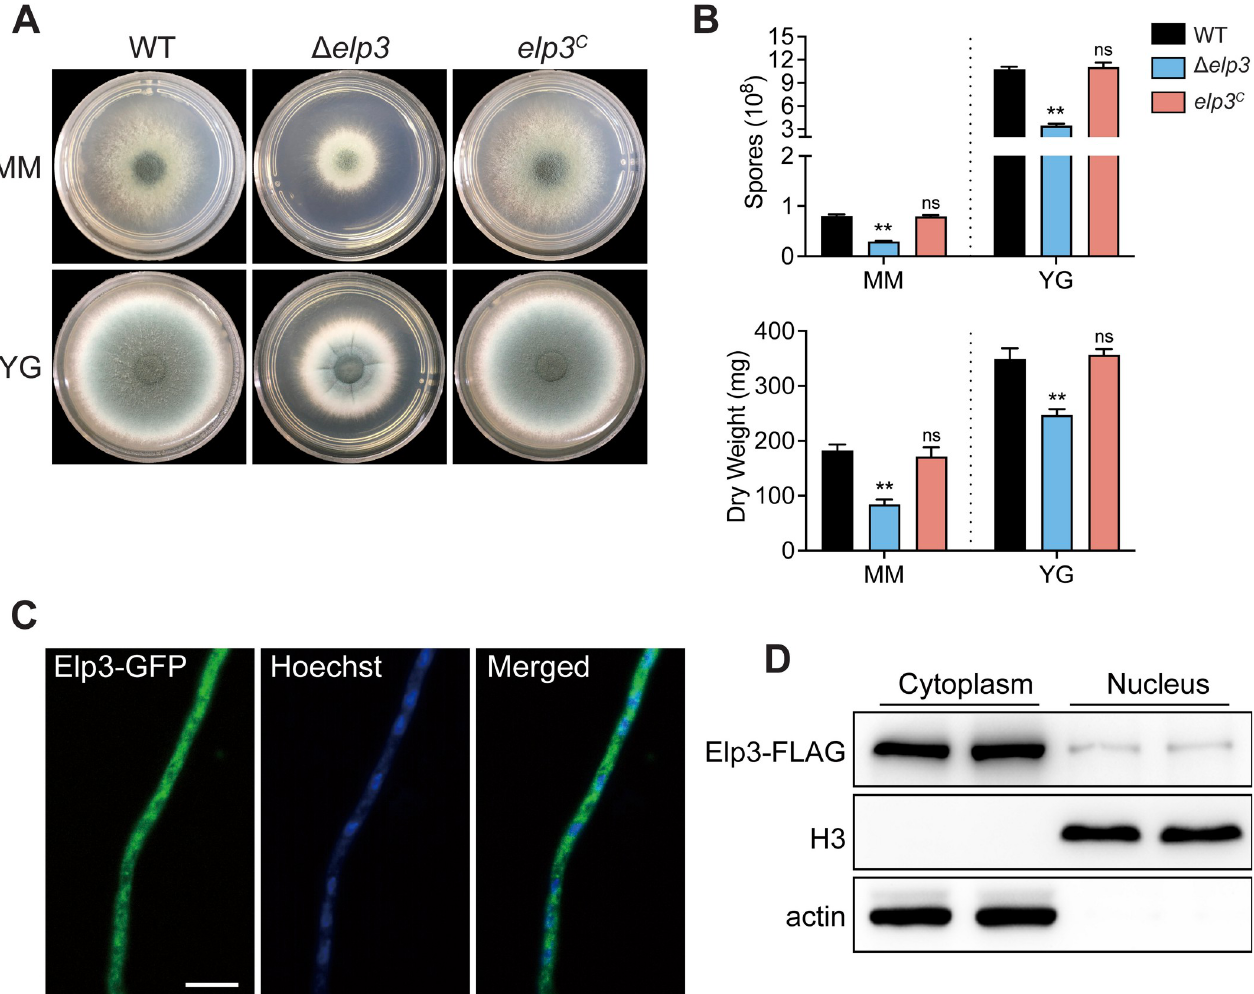
Fig 1. Elp3 is important for hyphal growth and conidiation in A . fumigatus . (A) Growth phenotypes of the wild-type, Δ elp3 and complementation strains on solid and liquid minimal medium (MM) and complete YG medium at 37˚C for 48 h. (B) Quantitative examination of spore production and biomass of the indicated strains. The data are presented as the mean ± SEM (standard error of the mean) of three independent experiments. Statistical analysis was performed using one-tailed, unpaired t tests. �� p < 0.01; ns, not significant. (C) Localization of Elp3-GFP. Nuclei were stained with Hoechst 33258 stain. Scale bar = 10 μ m. (D) Western blotting analysis of the distribution of Elp3 by subcellular fractionation. Actin and histone H3 were used as loading controls for the cytoplasmic and nuclear fractions, respectively.